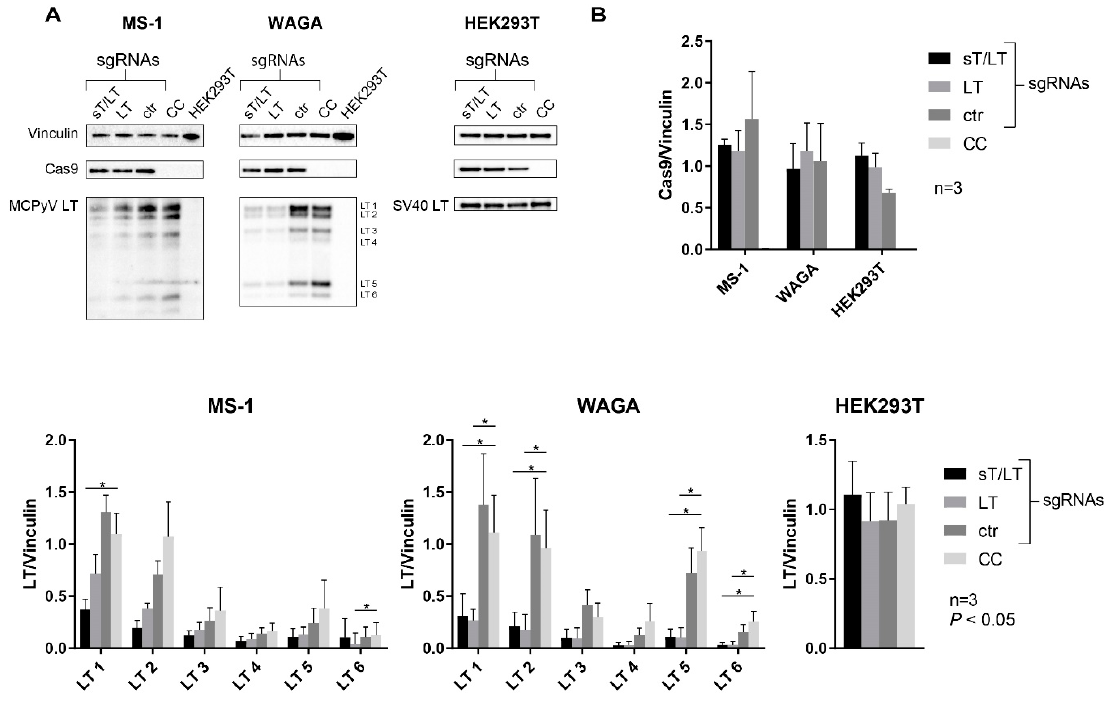
Figure 3. CRISPR/Cas9-mediated downregulation of MCPyV LT in MCPyV-positive (MCPyV + ) MCC cells expressing TAs-targeting sgRNAs. ( A ) LT expression was analyzed by western blot using total protein extracts from MCPyV + (MS-1 and WAGA) and MCPyV − (HEK293T) cells expressing Cas9 endonuclease (detected with an anti-V5 antibody) and the indicated sgRNA. Non-transfected cells (cell control or CC and HEK293T) were used as controls. Representative blots of three independent experiments are shown. Vinculin was used as internal loading control; ( B ) Densitometry analysis of normalized Cas9/Vinculin and LT/Vinculin. As indicated in panel A, for MCPyV + cells the different LT isoforms are enumerated from 1 to 6. Data represent mean values ± SD fromthree independent blots. Statistical significance compared with cell control (CC) is indicated.